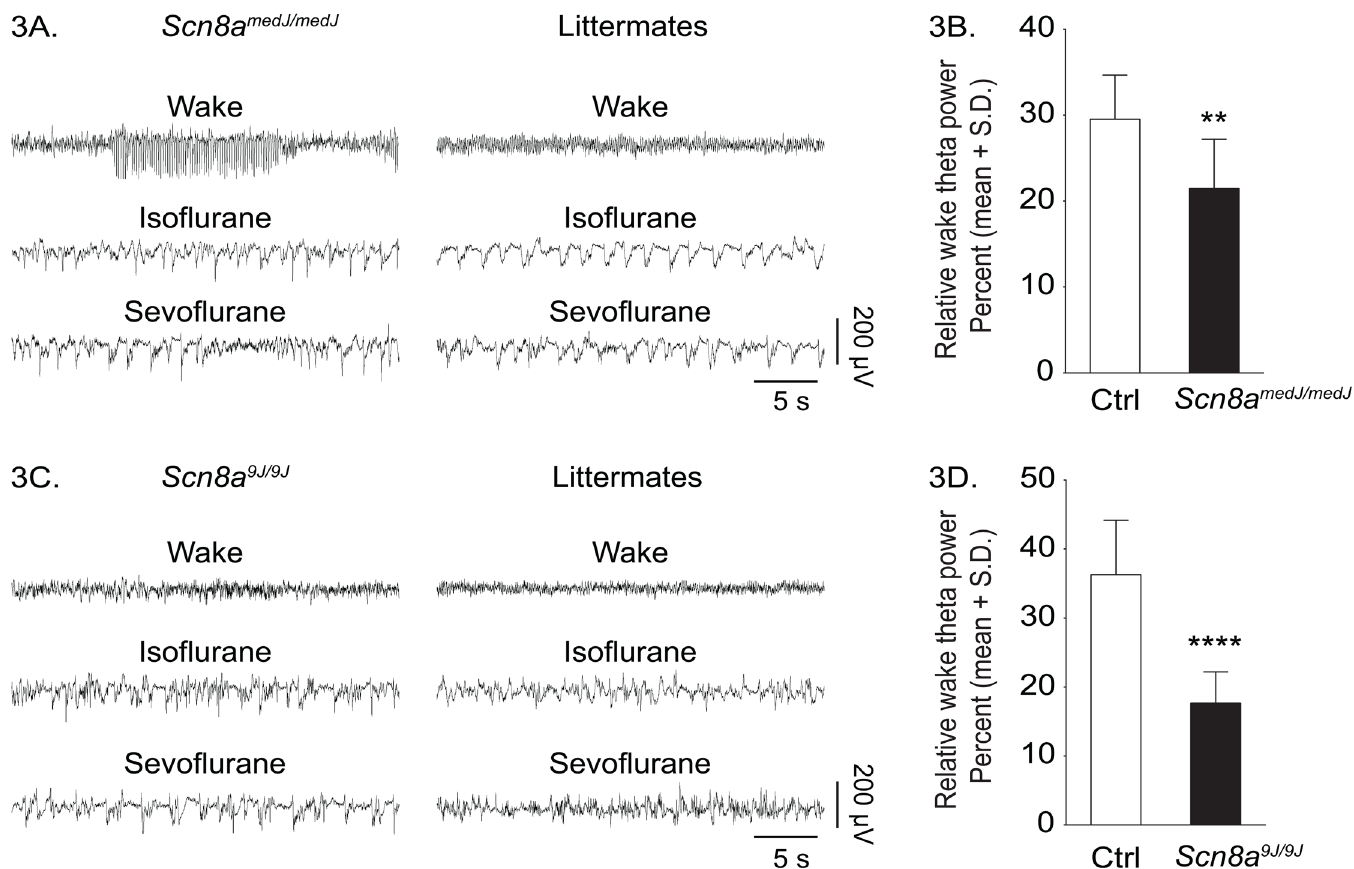
Fig 3. Effect of Scn8a medJ and Scn8a 9J mutations on qualitative and quantitative changes in EEG. Representative EEG traces (frontal-parietal derivation) during wake, isoflurane and sevoflurane anesthesia from Scn8a medJ/medJ mice and the littermate control group (A) , and Scn8a 9J/9J mice and the littermate control group ( C) . Both Scn8a medJ/medJ (B) and Scn8a 9J/9J (D) mice show significantly lower theta (4 – 10Hz) power during waking. ** p = 0.001, **** p < 0.0001 compared to littermate control group (Ctrl). S.D. — standard deviation.